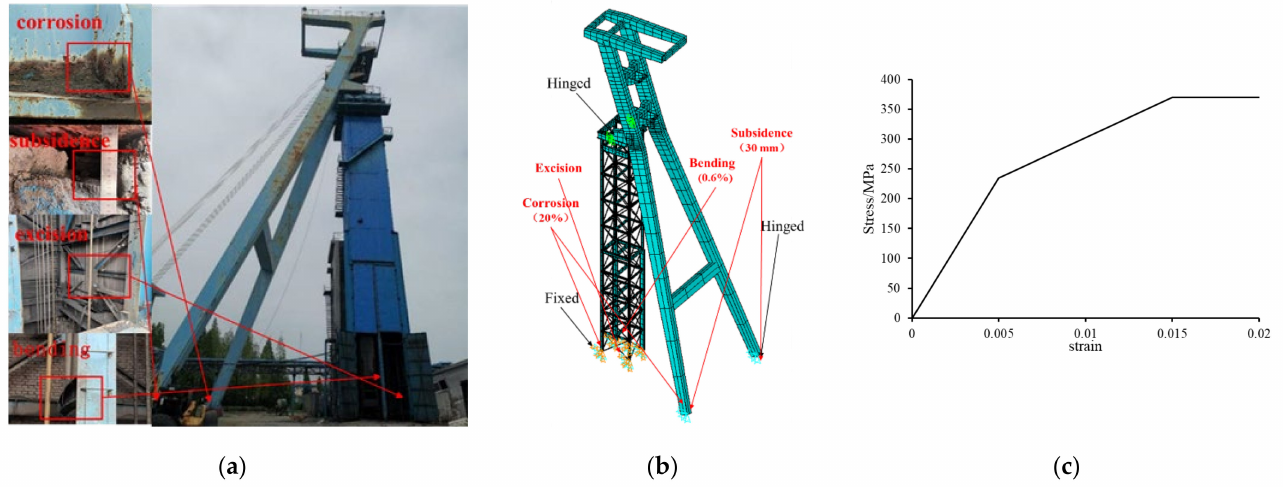
Figure 3. A scene diagram and finite element model of headframe. ( a ) scene diagram of headframe; ( b ) finite element model of headframe; ( c ) Calculation diagram of steel material properties.